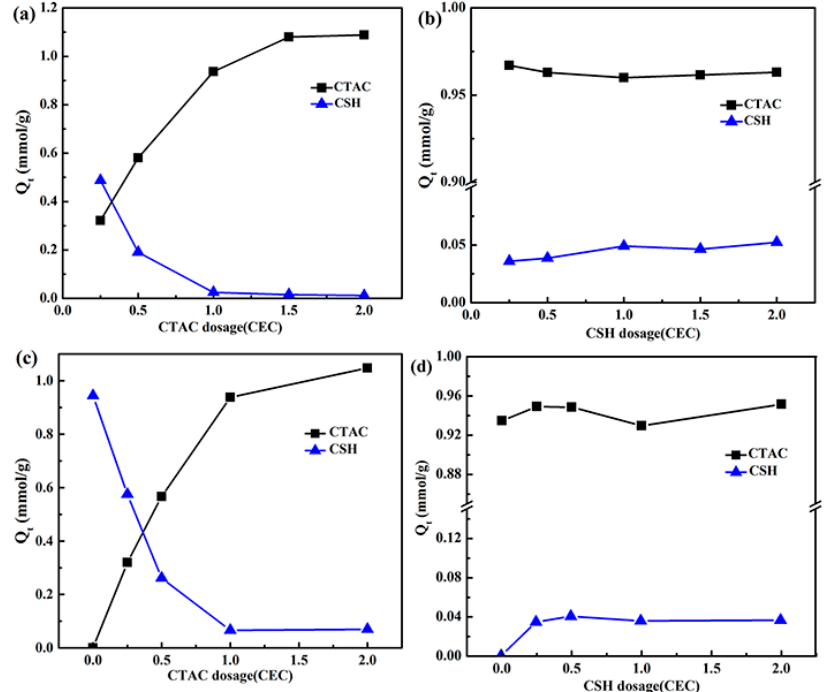
Figure 1. Effect of the order of addition and the mount of added modifiers on the CTAC or CSH adsorption amounts ( Q t ) by different samples: ( a ) CTAC x -CSH-Mt, ( b ) CSH x -CTAC-Mt, ( c ) CTAC x -CSH-coMt, and ( d ) CTAC-CSH x -coMt.